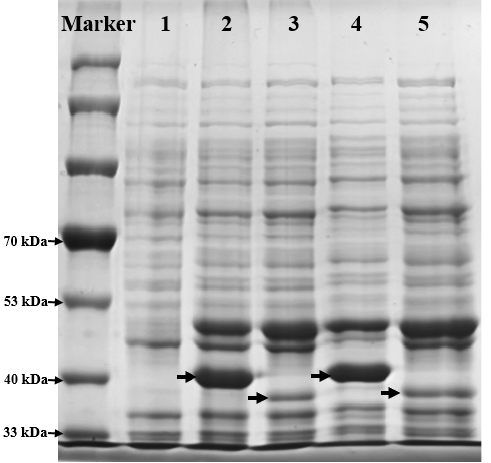
Figure 5. SDS-PAGE analysis of total cell lysates and the soluble constituents of BL21(DE3)-pETDuet- dldh - fdh and BL21(DE3)-pETDuet- hppr - fdh . Total cell lysates of BL21(DE3) were used as control ( lane 1 ); total cell lysates and soluble constituents of BL21(DE3)-pETDuet- dldh - fdh were loaded in lanes 2 and 4 , respectively; total cell lysates and soluble constituents of BL21(DE3)-pETDuet- hppr - fdh were loaded in lanes 3 and 5 , respectively; bands indicated by arrows in lanes 2 and 4 were recombinant D-LDH; the theoretical protein size was 37.2 kDa; bands indicated by arrows in lanes 3 and 5 were recombinant HPPR; the theoretical protein size was 35.4 kDa. The same amounts of cells were loaded in all lanes. All cells were induced using 0.5 mM IPTG at 28 °C and 150 rpm for 6 h.